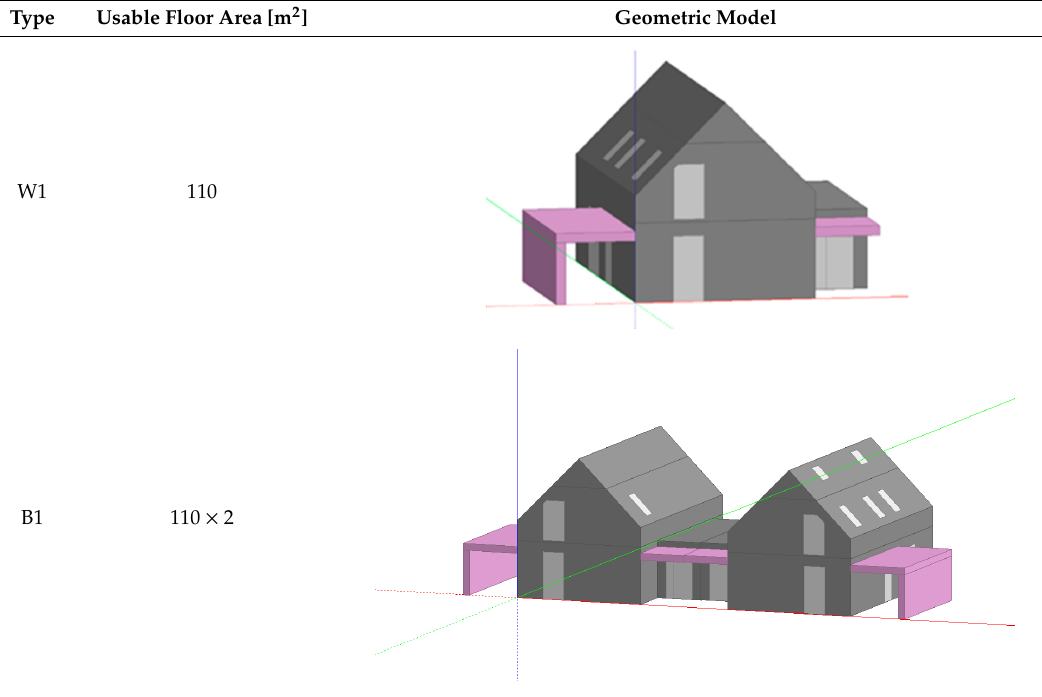
Table 3. Geometric models of the analysed buildings.